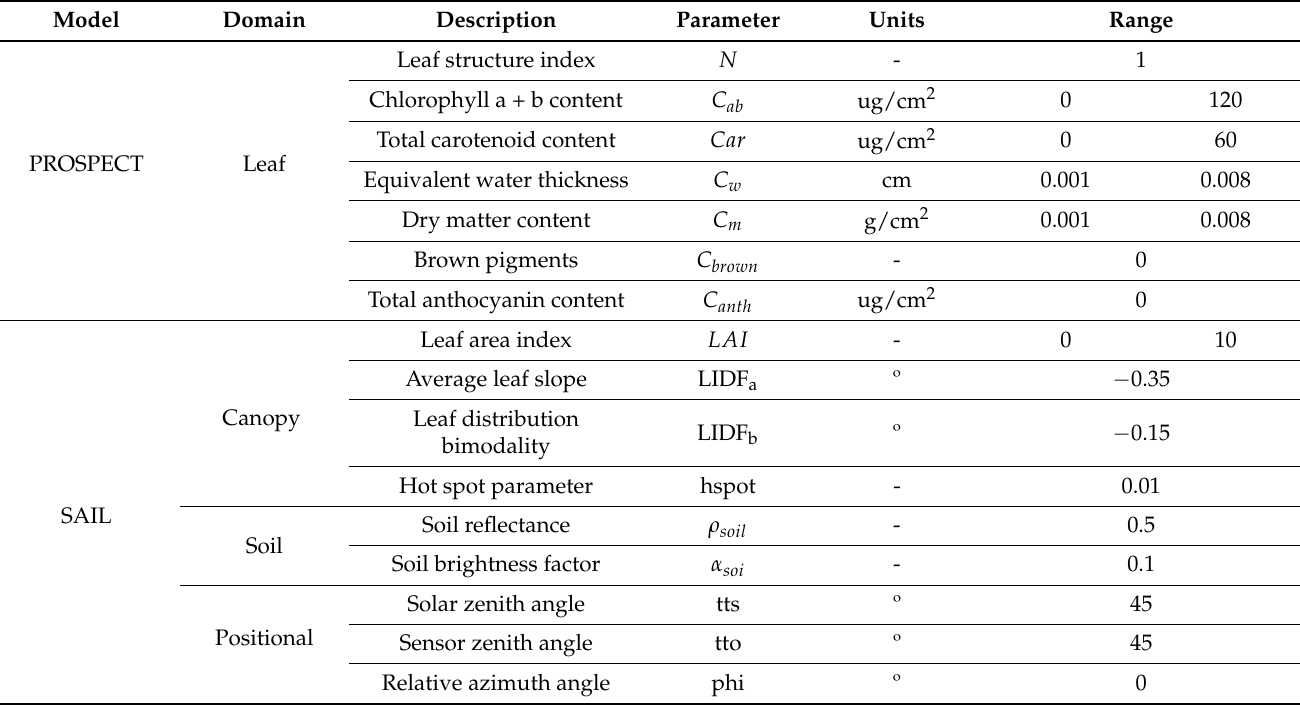
Table 1. Overview of PROSAIL input parameters used. Trait combinations were sampled representatively using a Latin hypercube sampling approach across the range identified. For the ML sections, Car was fixed at 10.